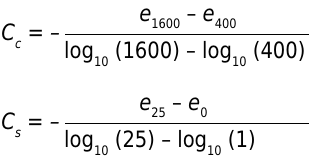
o i a t r d o i V